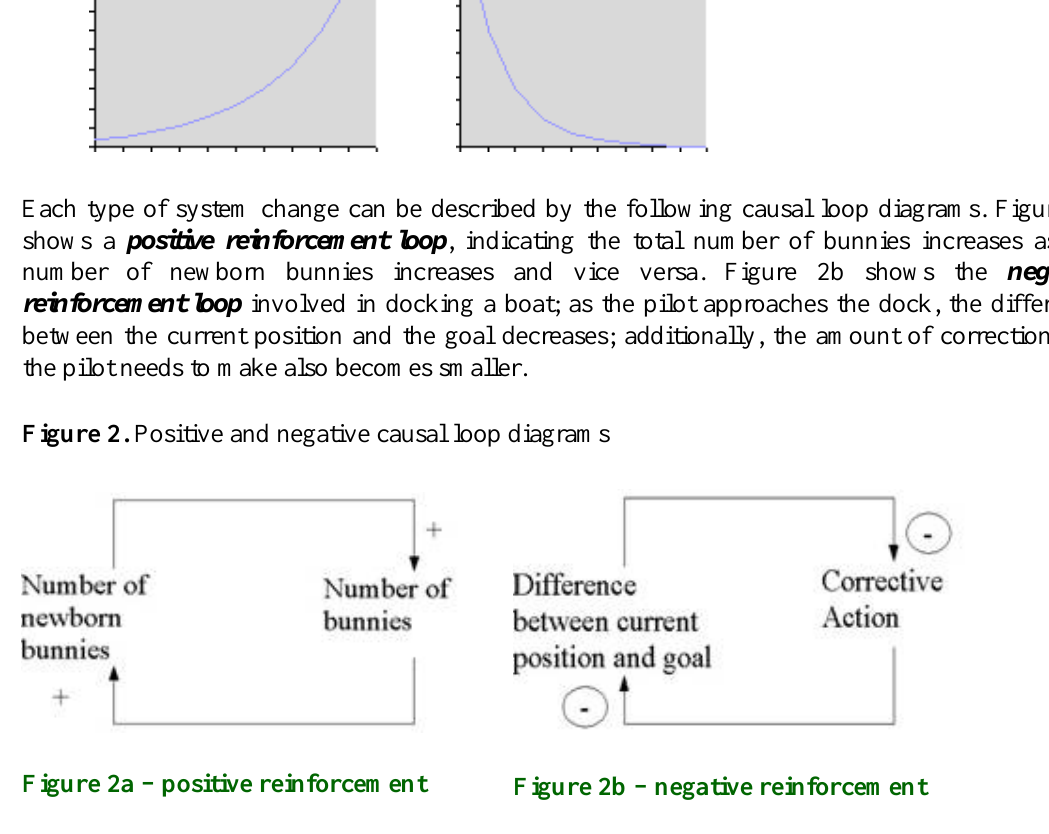
Figure 2a – positive reinforcement Figure 2b – negative